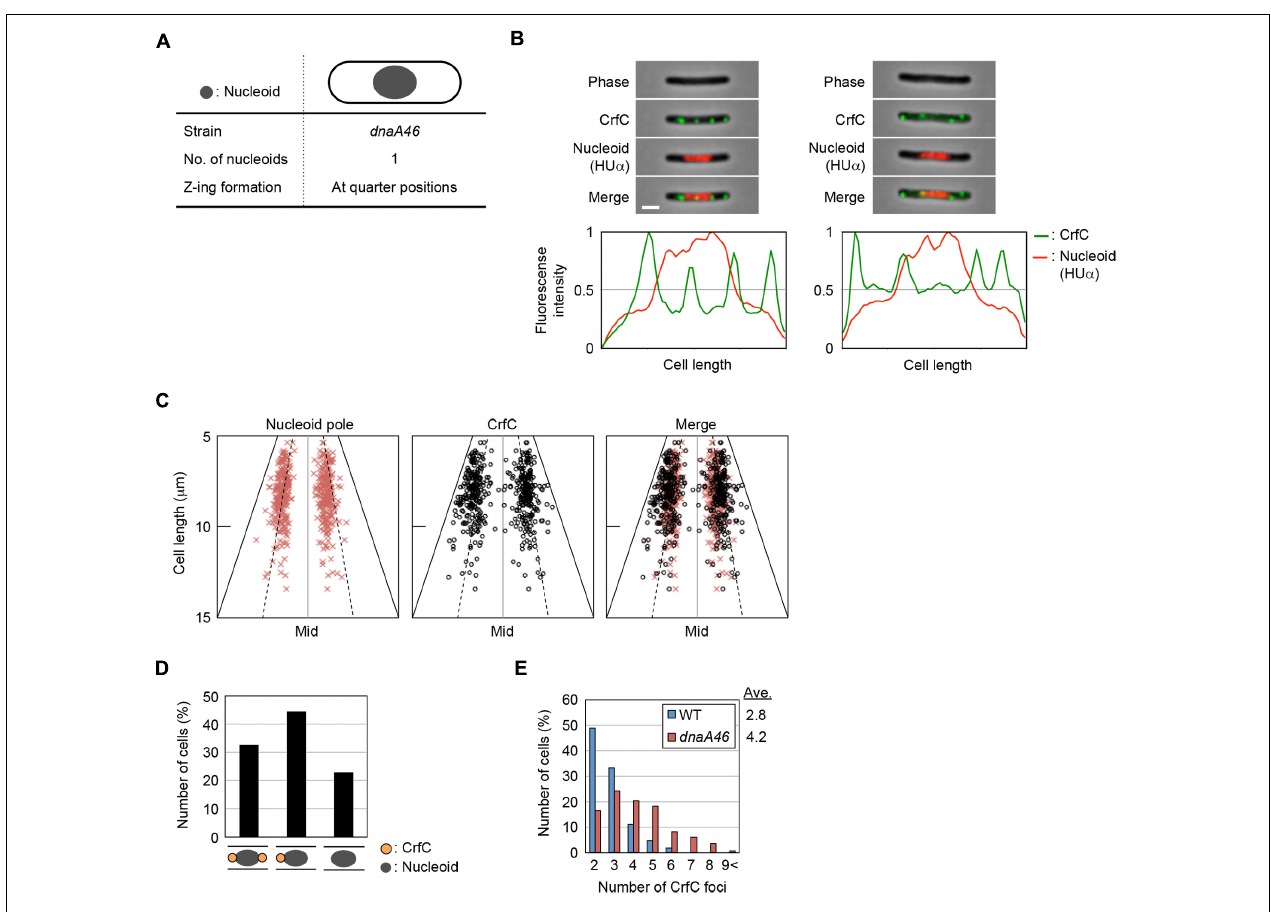
FIGURE 4 | Localization of CrfC and the nucleoid in dnaA46 filamentous cells. (A) Characteristics of dnaA46 cell incubated at the non-permissive temperature (42 ◦ C). When dnaA46 cells growing at the permissive temperature were transferred to 42 ◦ C and then incubated for a few more hours, the majority of cells contained a single nucleoid at mid-cell, and cell division (but not transcription and translation) was inhibited, resulting in elongated cells with an elongated space between the nucleoid poles and cell poles. Gray circle indicates the nucleoid. (B) Localization of CrfC foci and the nucleoid in MECS135 ( dnaA46 ) cells incubated at 42 ◦ C for 2 h after growing exponentially at 25 ◦ C. Cells were analyzed by fluorescence microscopy, and the normalized fluorescence intensities of CrfC foci (green line) and the nucleoid (red line) along the length of the cell were plotted. Images of cells with four CrfC foci are shown in the upper panels, and the corresponding fluorescence intensities are shown in the lower panels. Scale bar is 2 µ m. (C) Subcellular positioning of nucleoid poles and the CrfC foci adjacent to each nucleoid pole in MECS135 ( dnaA46 ) cells. Left panel: positions of the nucleoid poles; middle panel: positions of CrfC foci adjacent to each nucleoid pole; right panel: merge of left and middle graphs. The quarter-cell positions are indicated by dotted lines. Mid, mid-cell. (D) Percentages of cells with two, one, or no CrfC foci at each nucleoid pole in MECS135 ( dnaA46 ) cells. (E) Percentages of MECS133-K [wild-type dnaA (WT)] or MECS135 ( dnaA46 ) cells containing the indicated number of CrfC foci. Numbers of cells analyzed: 326 (WT) and 236 ( dnaA46 ). Ave; the average number of CrfC